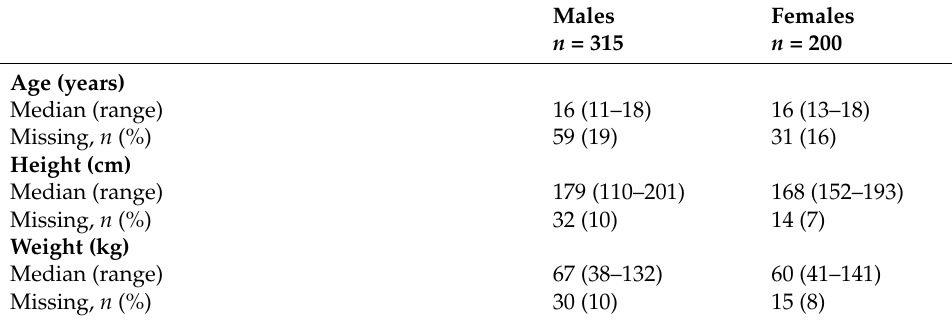
Figure 1. Flow chart of players through the study. Table 1. Player baseline characteristics by